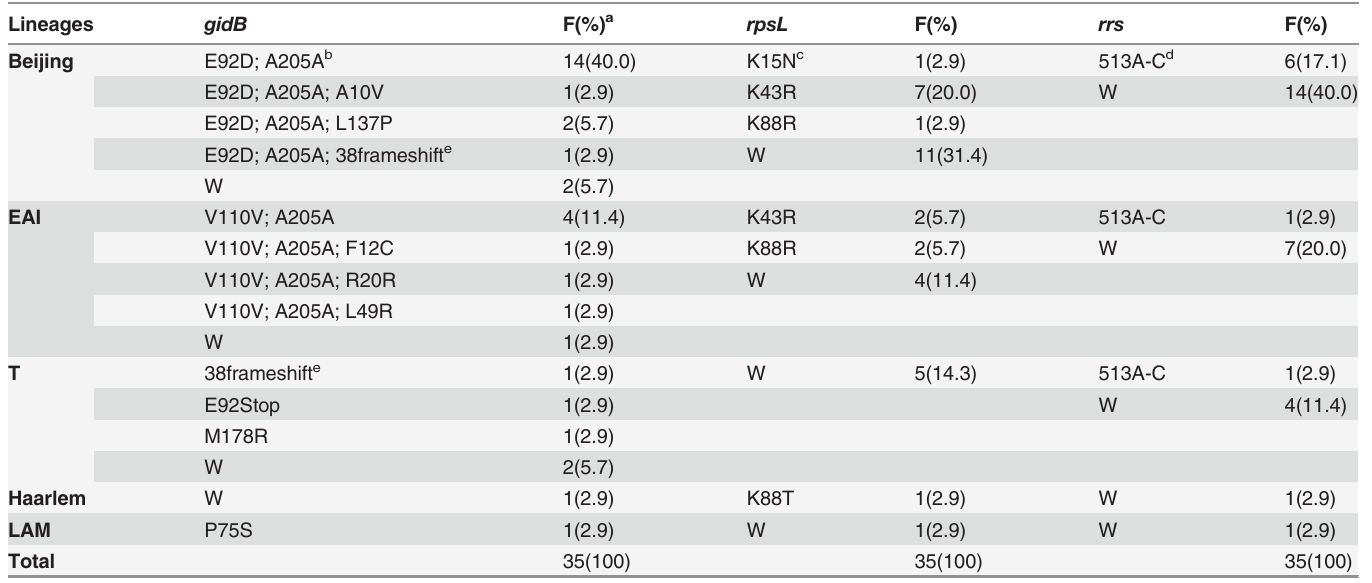
Table 4. Mutation frequencies of gidB , rps L and rrs genes in different MTBlineages.